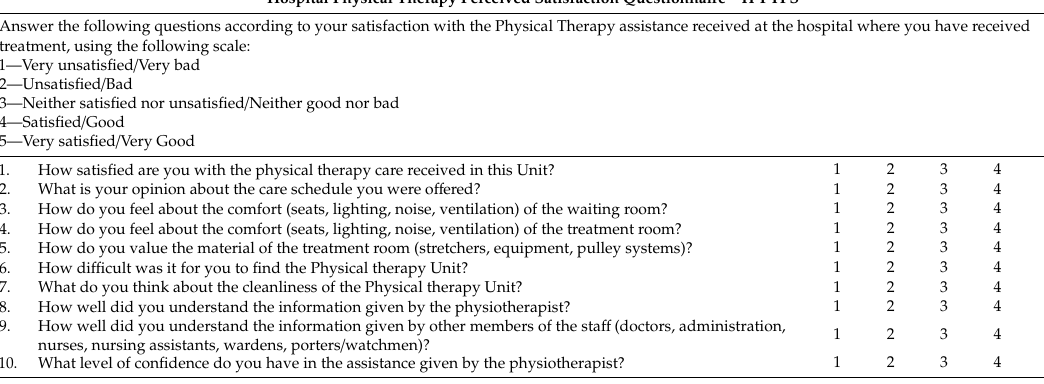
Table 4. Evaluator manual and the items of the English translation of the Hospital Physical therapy Perceived Satisfaction